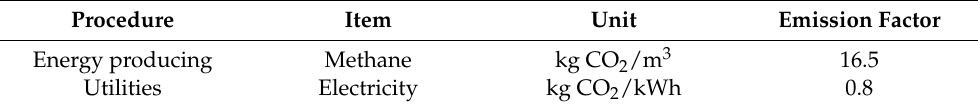
Table 5. Factors used in calculating greenhouse gas emissions by Jiang et al.